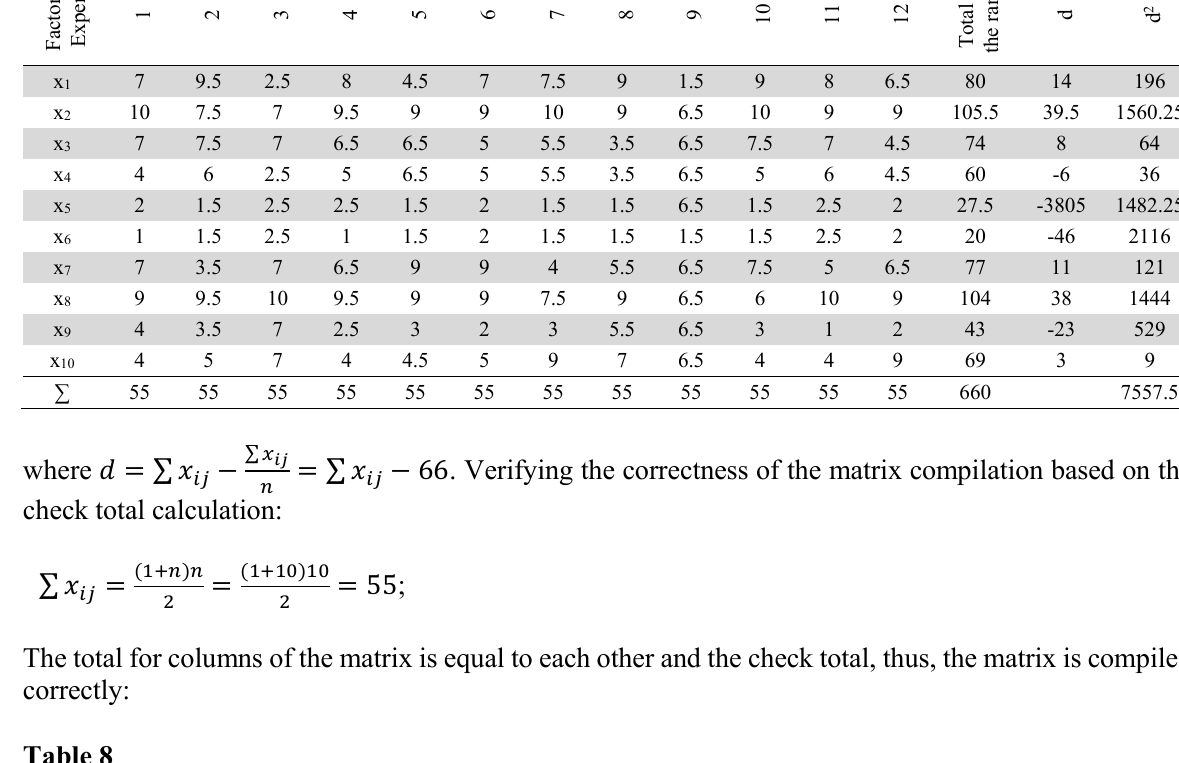
Final Indices of the Ranking of Matrix Elements Name of the block Total for the ranks Name of the block Total for the ranks x